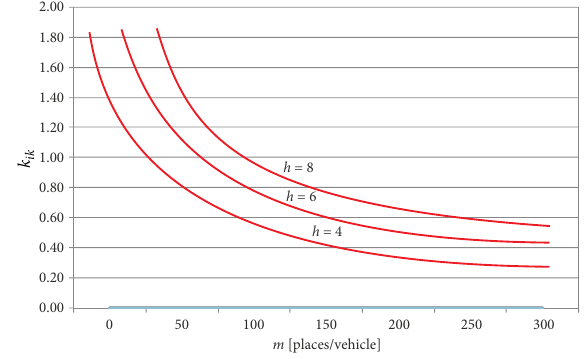
Figure 4. Comfort change ( k ik ) as the function of vehicle capacity ( m ) for different values of headways ( h ) and for number of transported passengers ( P = const) and passengers’ change coefficient ( h = const) (Tica